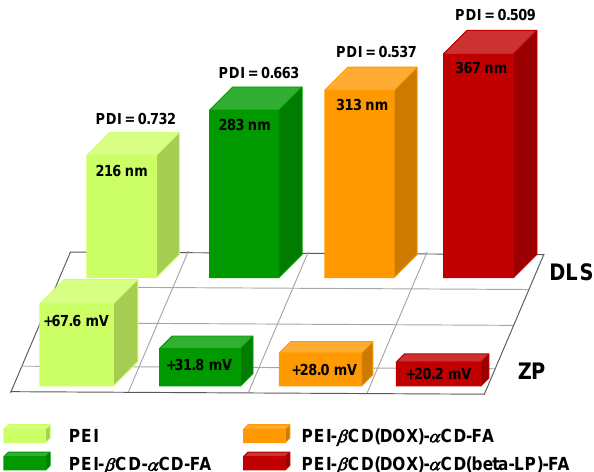
Figure 4. Hydrodynamic diameter values determined from DLS measurements and zeta potential values for PEI, PEI- β CD- α CD-FA nanocarrier, PEI- β CD(DOX)- α CD-FA, and PEI- β CD(DOX)- α CD(beta-LP)-FA nanoconjugates obtained in 0.02 M PBS buffer.